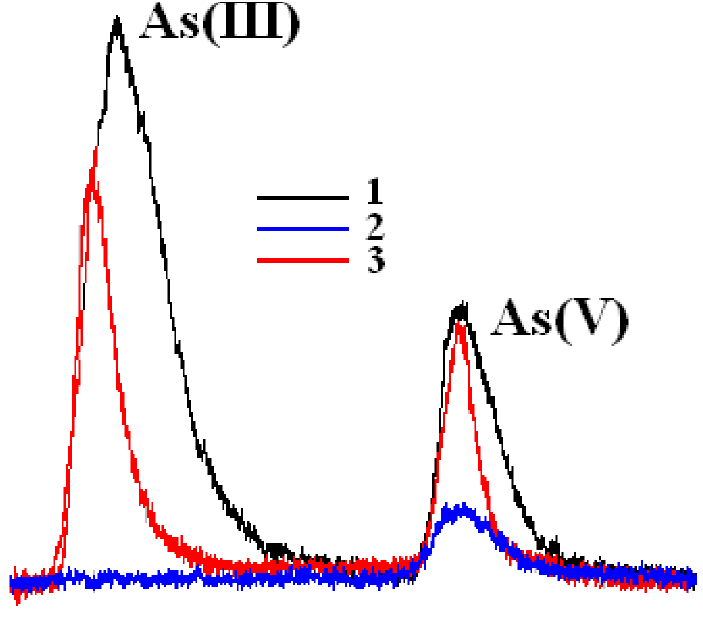
Fig. 2 Chromatograms of two arsenic forms As(III) and As(V) (corresponding with Table